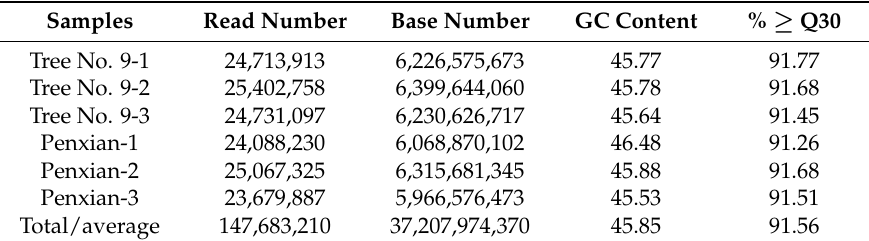
Table 1. Statistical table of all samples sequencing data.